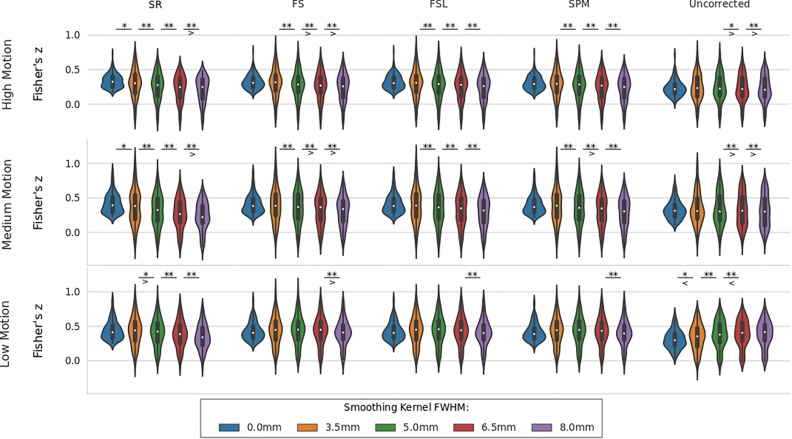
The effect of spatial smoothing on real data with STC. Violin plots show the resulting z-scores from the voxels with the top 20 t-statistics for 30 real data sets (10 low motion, 10 medium motion, 10 high motion) processed with smoothing kernels of 0, 3.5, 5, 6.5, and 8 mm. We examined the effect of smoothing for low, medium, and high motion levels (rows). For each motion/smoothing condition, statistics were compared across 5 STC conditions: Shifted Regressor, FS, FSL, and SPM STC methods were examined, as well as uncorrected data. For each motion level, the voxels with the top 20 t-statistics were identified from the unsmoothed Shifted Regressor case. The z-score of these 20 voxels are plotted for all other STC methods and all other smoothing conditions. The effect of smoothing is seen as a lowering of the mean z-scores, as well as reducing the variance across STC methods due to the distribution of slice-dependent errors. In real data, the “Gold standard” (Shifted Regressor) is outperformed by all other STC methods when large smoothing kernels are used. ‘<’ and ‘>’ Symbols indicate which mean is greater for cases that are not easily distinguishable.